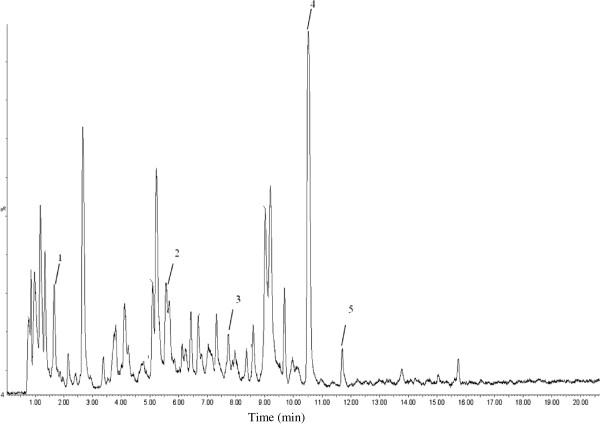
Typical HPLC-MS chromatogram of methanolic peel extract of pomegranate fruit. (1) Gallic acid; (2) Catechin; (3) Epicatechin; (4) Ellagic acid; (5) Rutin.